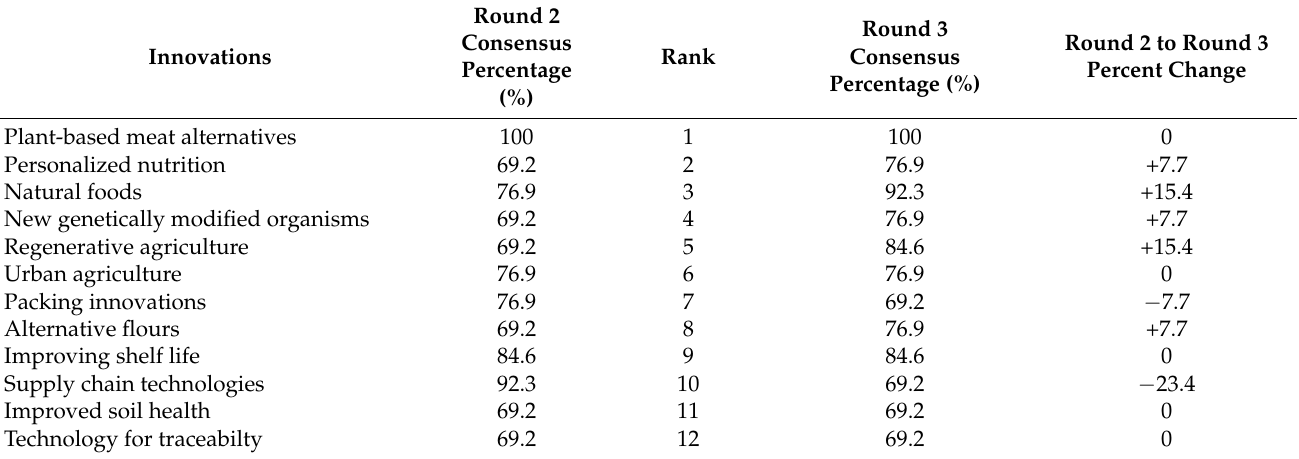
Table 3. Rank of specific food innovations likely to be available to consumers in the next five